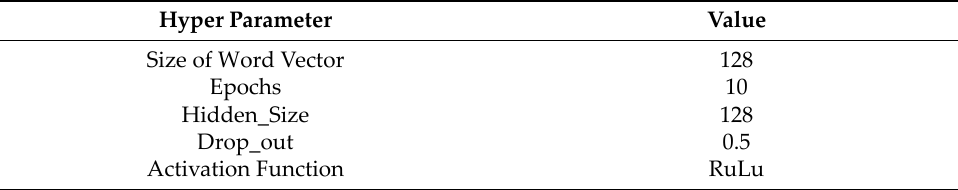
Table 2. Bi‑LSTM bidirectional channel model super parameter setting table.